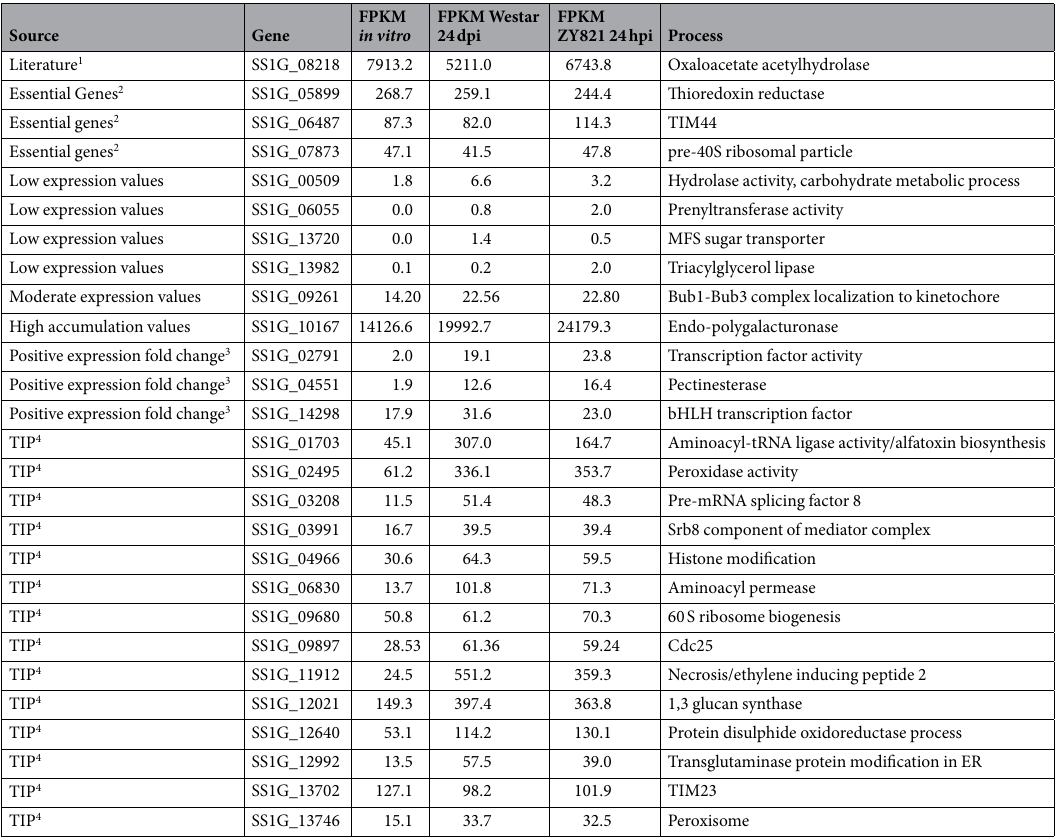
Table 1. Selected list of S . sclerotiorum t arget genes for RNA interference testing in liquid culture, and infection assays on B . napus and A . thaliana . ( 1 ) Liang et al . 29 ; ( 2 ) Database of Essential Genes (www.essentialgene.org) 45 ; ( 3 ) Positive fold change in response to in planta growth ( 4 ) TIP = Target identification pipeline (Table